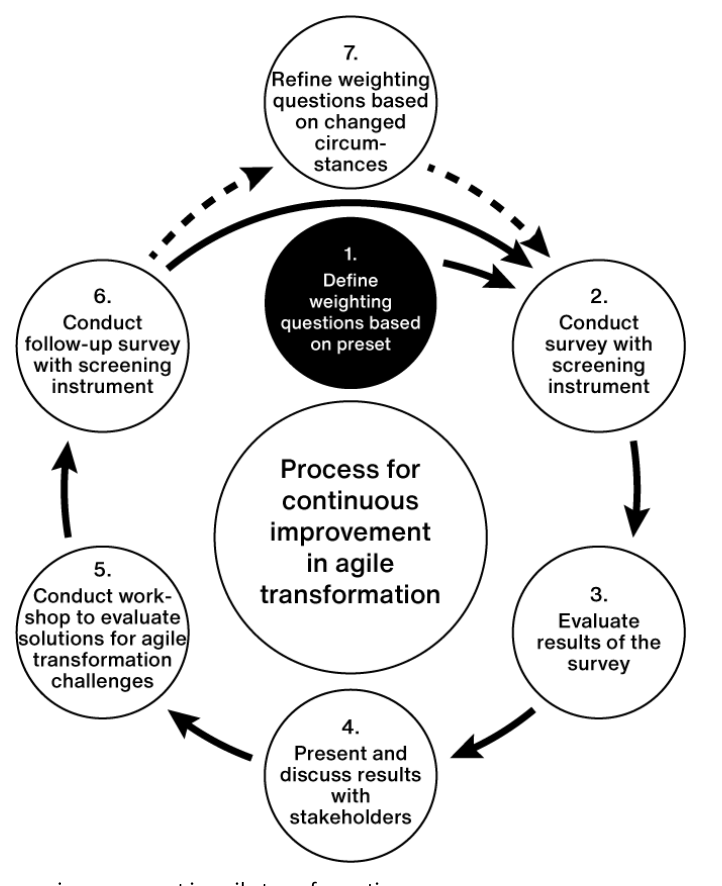
Figure 1. Process for continuous improvement in agile